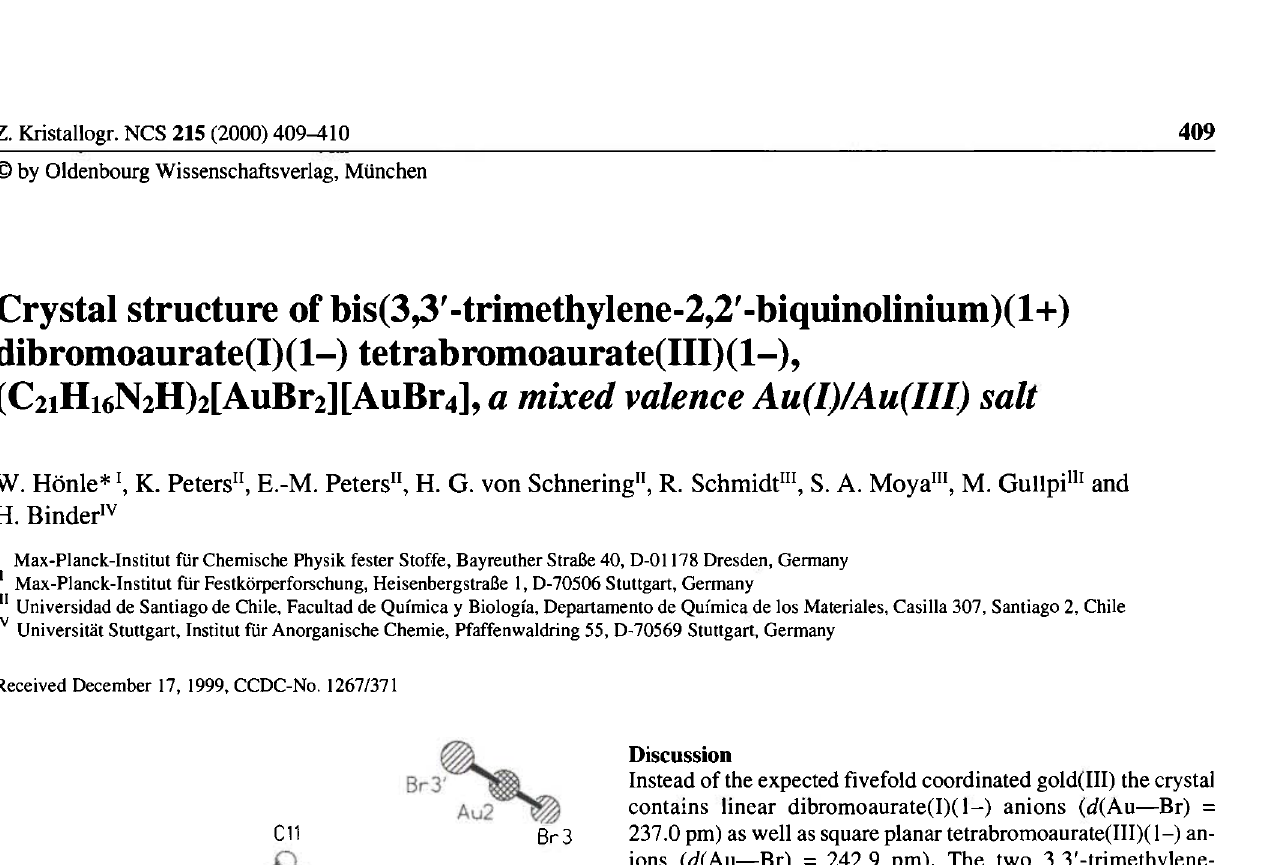
Table 1. Data collection and handling.